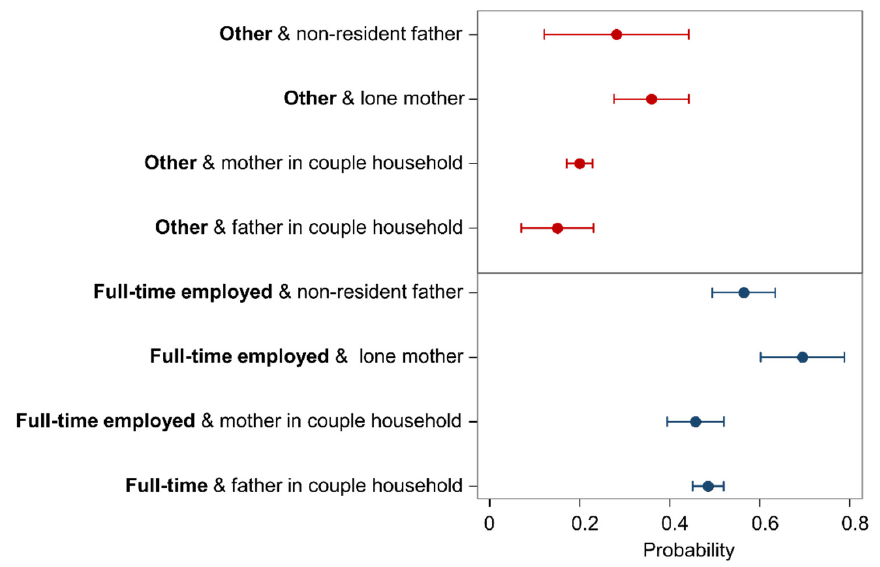
Figure 3. Average predicted probabilities from logistic regression model and 95%-confidence bounds, dependent variable: 1: concerns, 0: no concerns. Note: Effects were controlled for parental education, number of children, age of children, region.